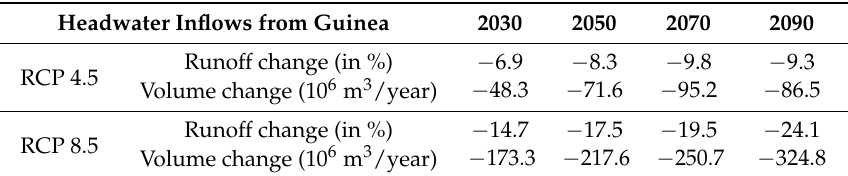
Table 3. Runoff variation for the next decades of the 21st